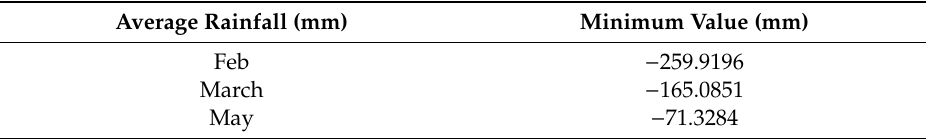
Table 11. Minimum value (mm).